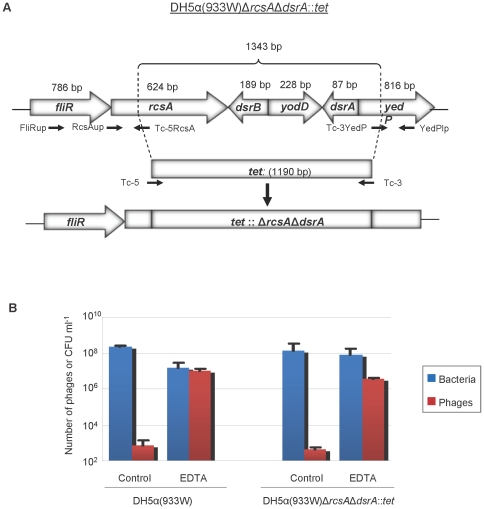
Evaluation of the effect of RcsA and DsrA on Stx2 phage induction.(A) shows the position and direction of the transcription of the rcsA and dsrA genes and the deletions used to generate mutant DH5α(933 W)ΔrcsAΔdsrA::tet. The map was drawn based on the distribution in E. coli strain K12 MG1655 (GenBank accession n° U00096.2). Their close position on the genome permitted the effect of both genes to be evaluated using a single mutation via the Red Recombinase system. The orientation and positions of primers used to construct mutants with deletions in rcsA and drsA genes by introducing a tet cassette are marked by small arrows. The extent of each deletion is shown but is not drawn to scale. (B) shows the number of 933 W phage and viable bacterial counts of the wild-type strain and the mutant with and without EDTA induction. Data presented are the mean of three experiments. Error bars indicate the standard deviation.